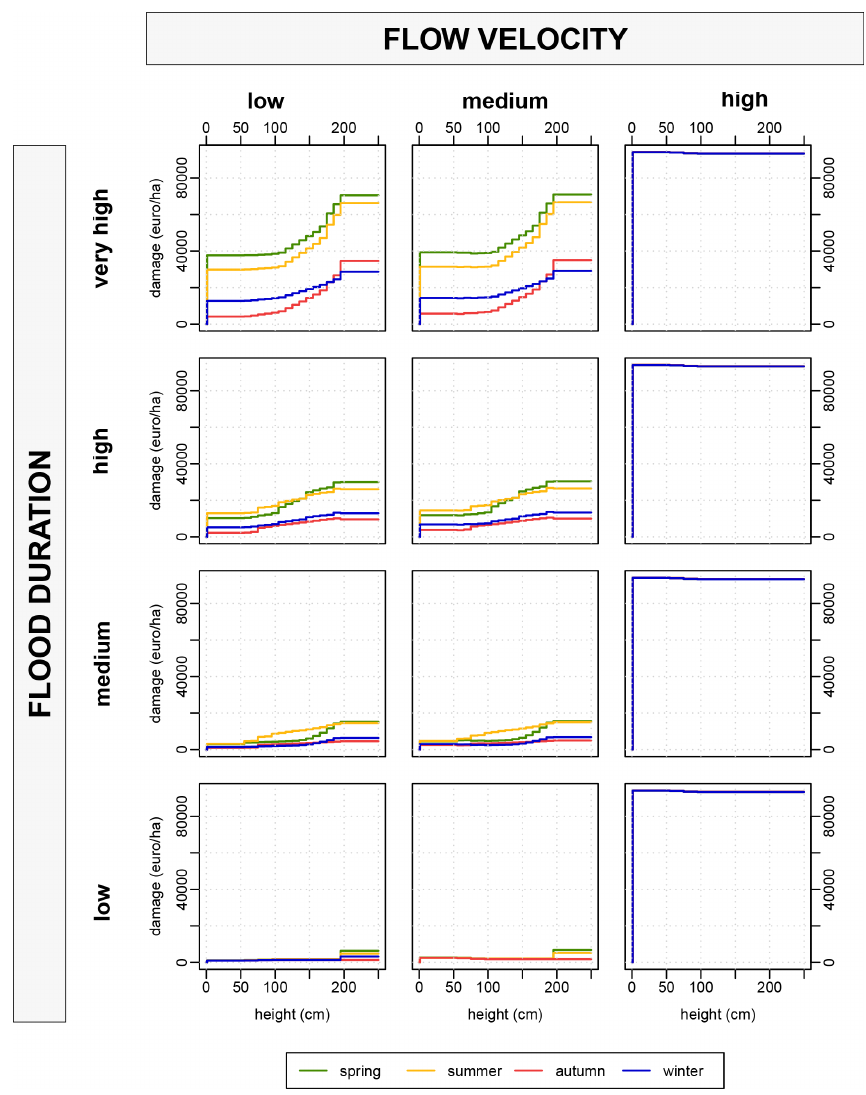
Figure 4. Example of the national flood damage function developed using floodam.agri for the category